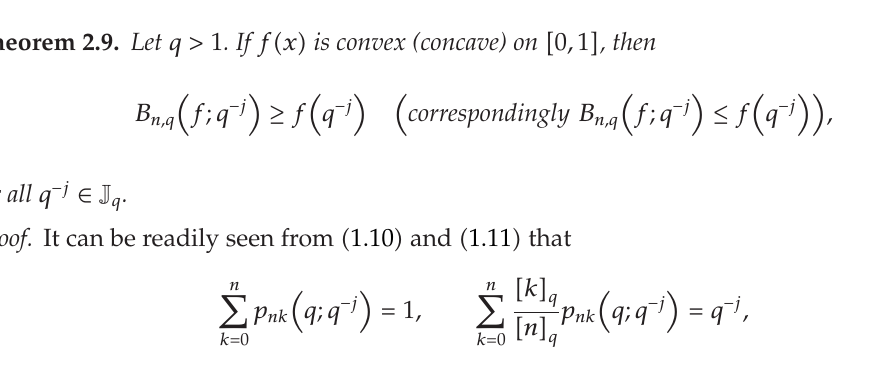
Figure 1: Graphs of y (cid:6) f (cid:2) x (cid:3) and y (cid:6) B n, 2 (cid:2) f ; x (cid:3) , n (cid:6) 4 ,